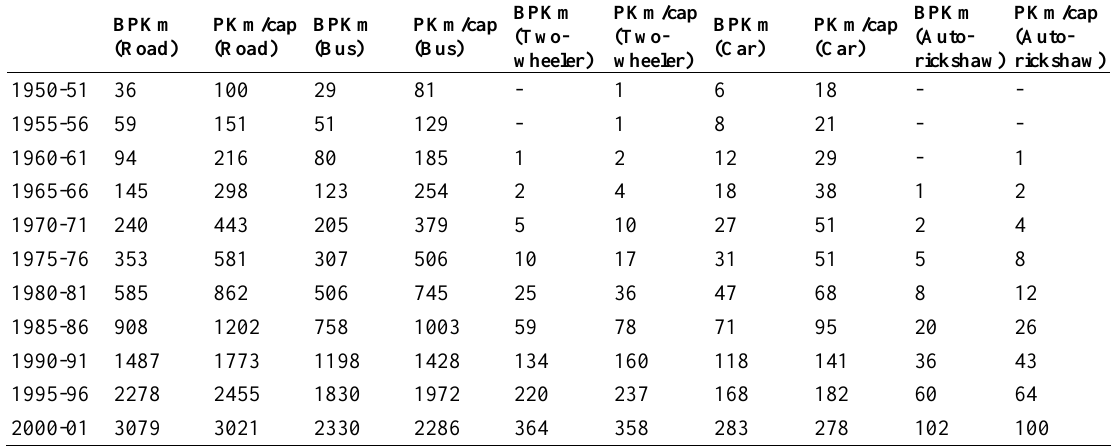
Note: All figures are rounded off to zero decimal place and (-) indicates negligible